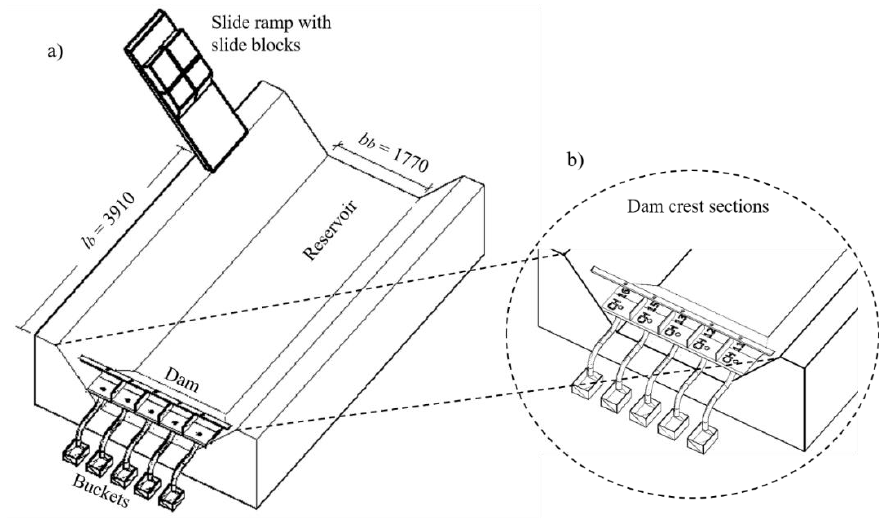
Figure 2. ( a ) Experimental setup with the main components; slide, reservoir, dam, and ( b ) ultrasonic sensors used for measuring the overtopping depth and buckets for collecting the overtopping water (all measurements are in mm). Table 1. Fixed parameters for the model setup (prototype scale).